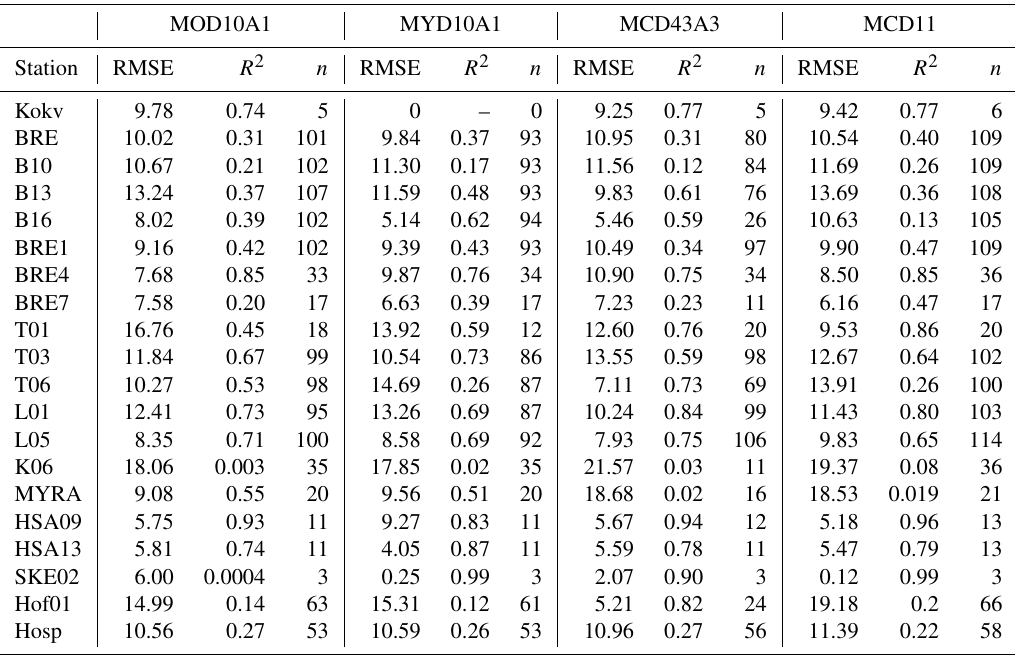
Table A1. RMSE, R 2 values, and number of months of overlapping data ( n ) for individual station comparison on a monthly time scale for MOD10A1, MYD10A1, MCD43A, and